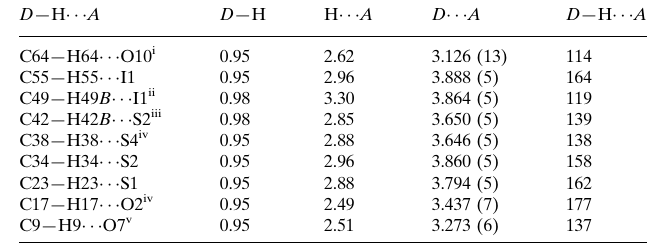
34152 measured reflections 12730 independent reflections 11088 reflections with I > 2 (cid:1) ( I ) R int = 0.042